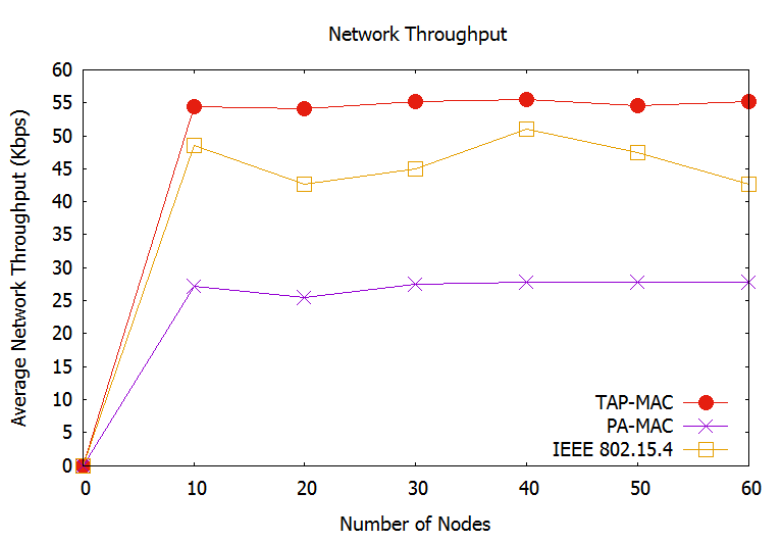
Figure 8. Scenario 1: Average network throughput.